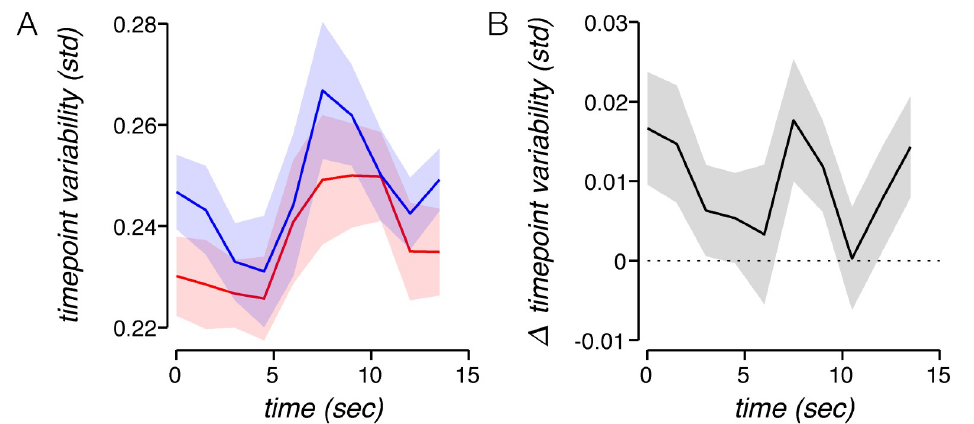
Fig 7. Higher reward decreases time-point variability dynamically throughout the trial. (A) Mean group time-point variability time series. At each time point, variability was computed per participant and then averaged. Time-point variability changes systematically throughout a trial, in a similar way for low-reward and high-reward runs. Shaded regions, ± SEM across participants. (B) High-reward time-point variability subtracted from low-reward time-point variability. Time-point variability was greater for low reward than for high reward across all time points, and the difference between the two exhibits a temporal profile similar to temporal variability for each of the two reward conditions. Shaded regions, ± SEM across participants. Underlying data can be found at https://osf.io/cbjq6/. std, standard deviation.